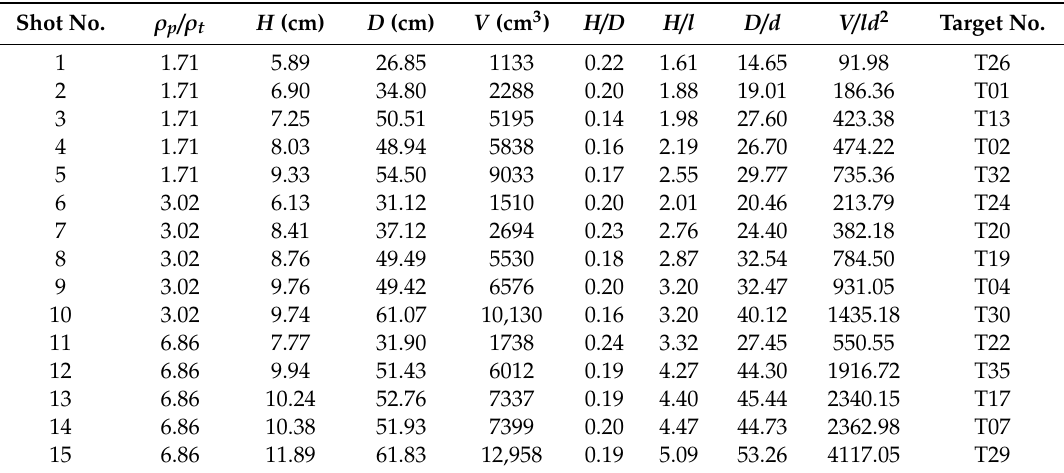
Figure 7. Three-dimensional (3D) digital elevation model of impact crater (Shot No. 10): ( a ) oblique view; ( b ) lateral view; ( c ) top view with depth contour lines.